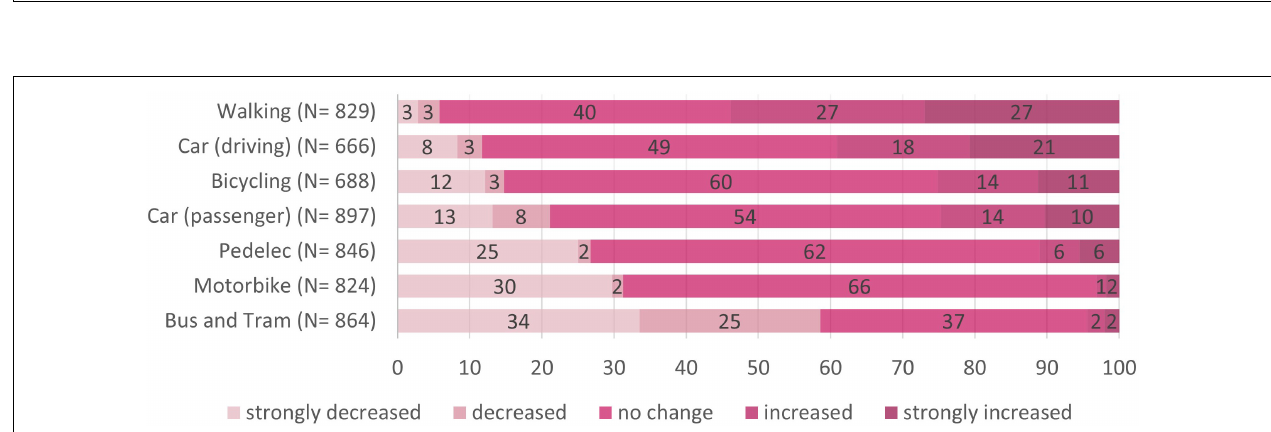
FIGURE 2 | Means of transportation used in the last month. N = 918; numbers on the bars represent percentages.